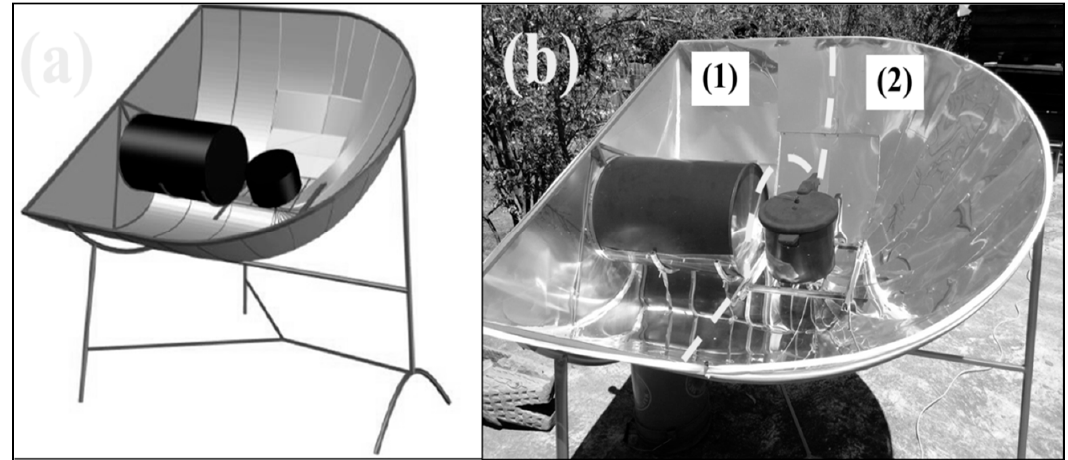
Figure 1. ( a ) Computer-assisted design of the MFSS; ( b ) fully-constructed